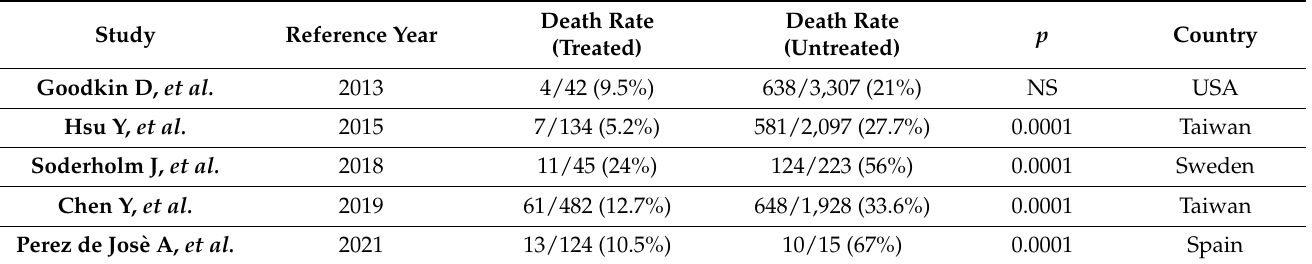
Table 1. The impact of antiviral therapy upon survival in HCV-positive patients who received antiviral therapy: univariate